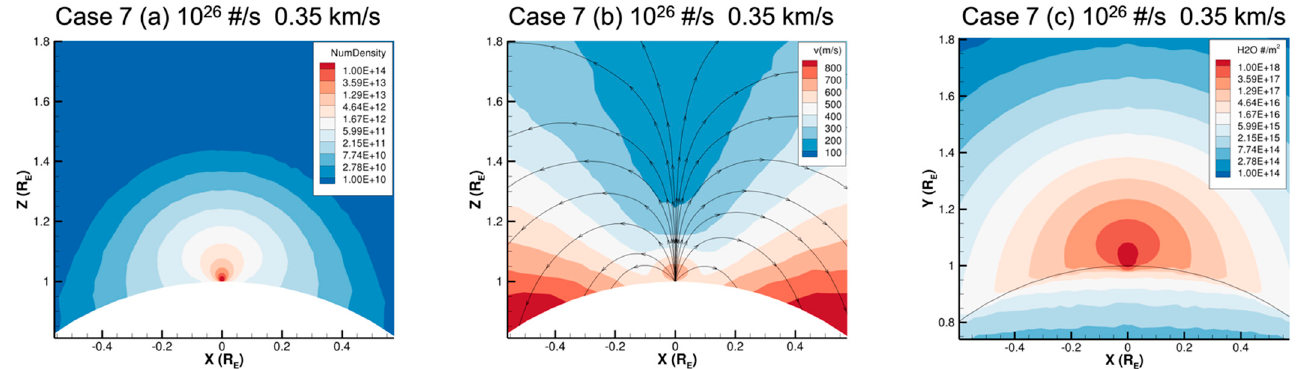
Figure 5. ( a ) Number density distribution (shown in contours with a color scale in units of # m − 3 ). ( b ) Gas velocity distribution (shown in contour with a color scale in units of m s − 1 ). Gas flow streamlines are presented too. ( c ) Column density integrated along a line of sight of 90 degrees from Europa’s pole (i.e., perpendicular to the paper). The contour is shown with a color scale in units of # m − 2 . Both axes are arbitrary and presented in units of Europa radius.